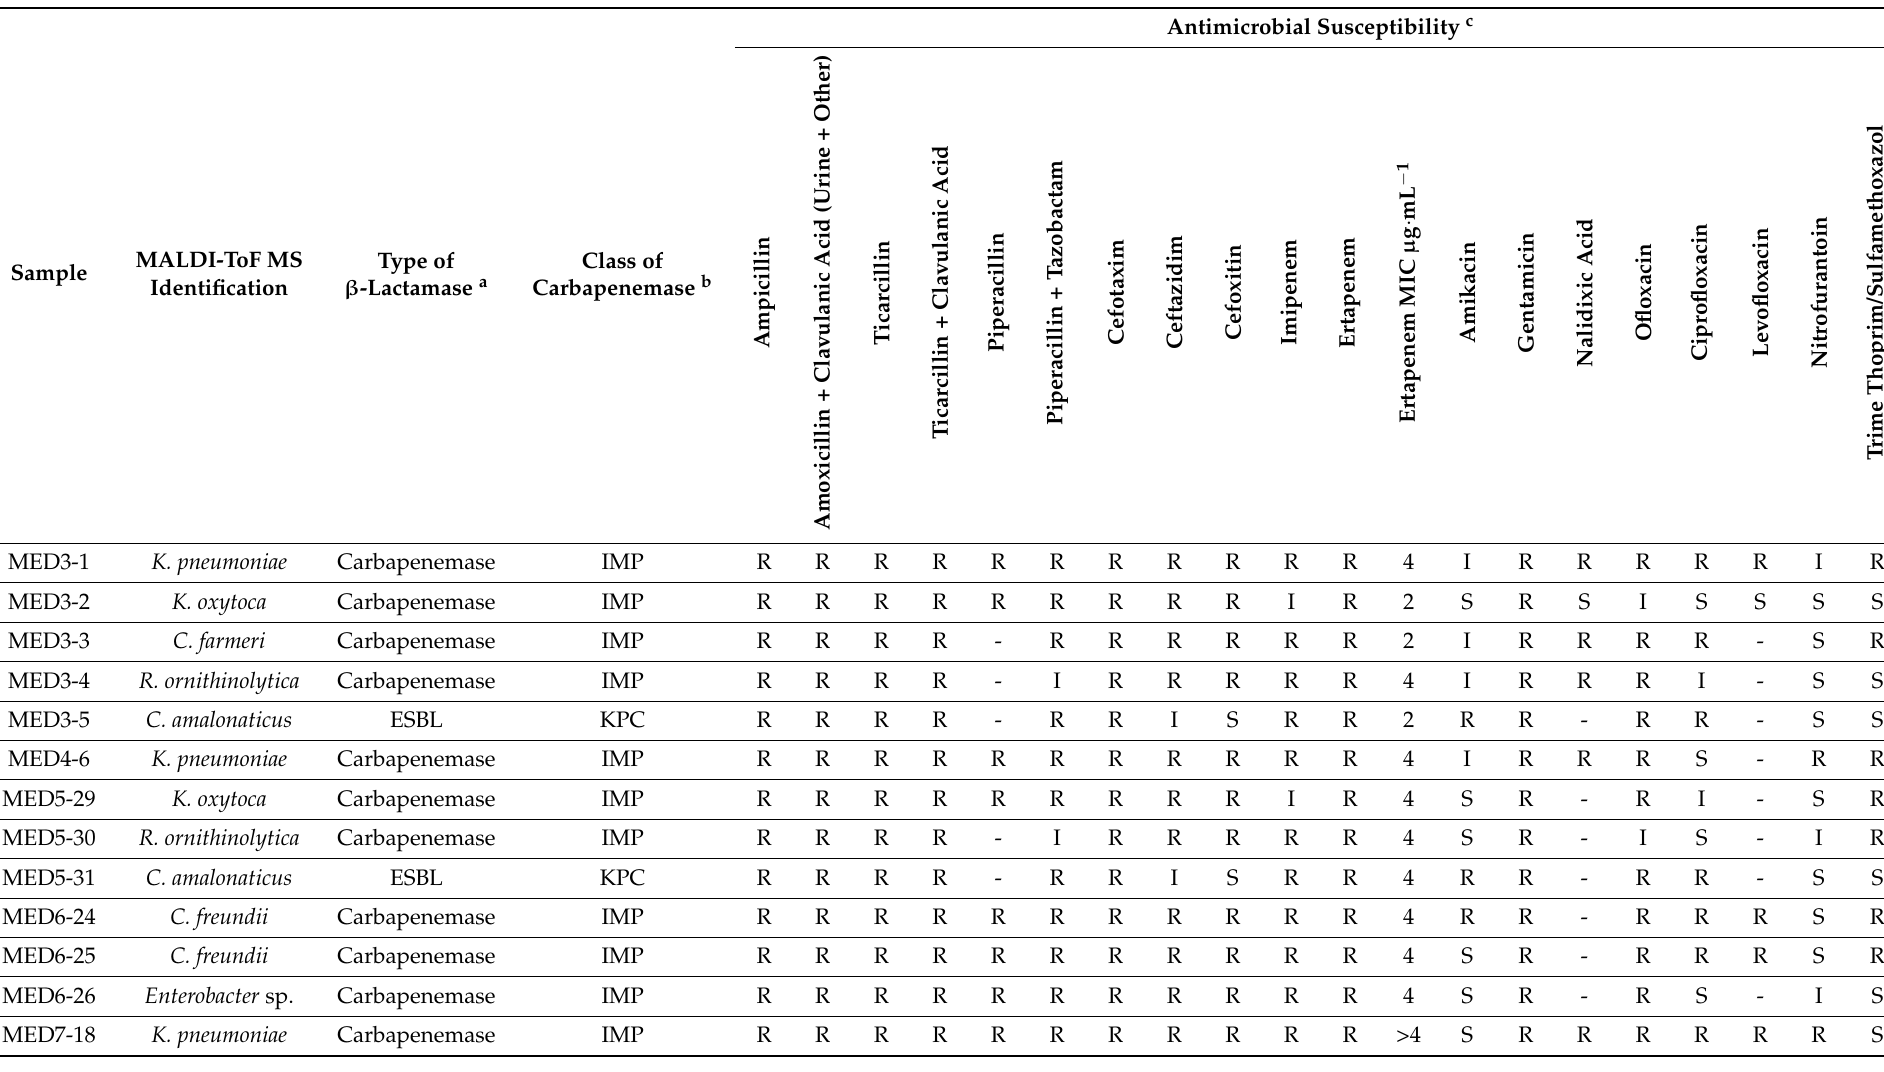
Table 4. Species, type of β -lactamase, ertapenem MIC, and carbapenemase’s class of presumptive CP-CRE isolated from wastewater